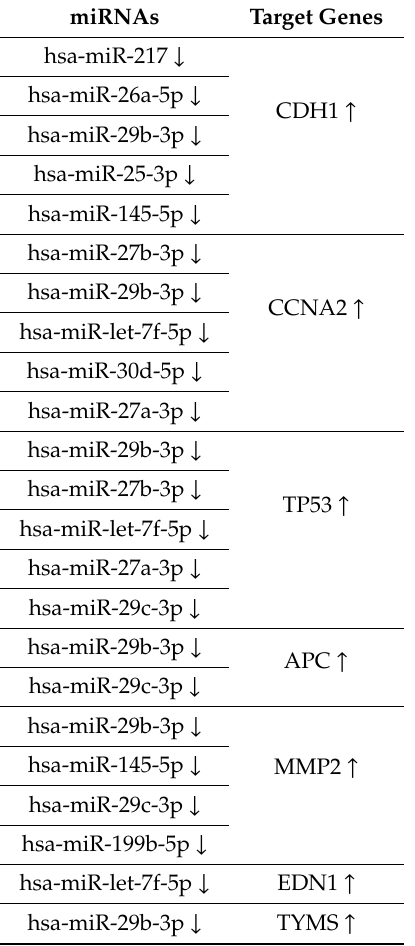
Table 2. List of deregulated miRNAs and their putative target genes.